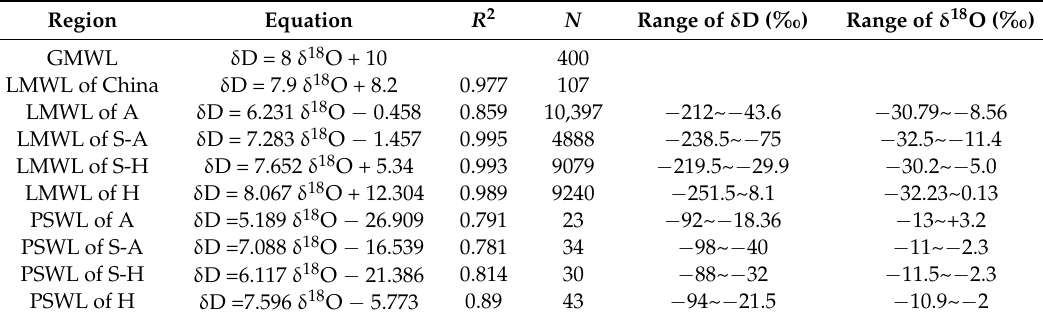
Table 1. The relationship between δ D and δ 18 O values for precipitation and plant stem